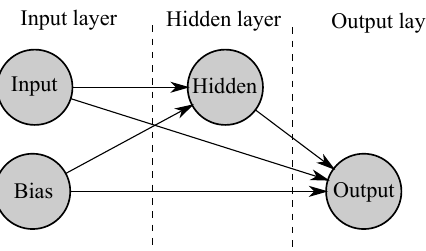
Figure 8. Topology of the proposed FCC neural